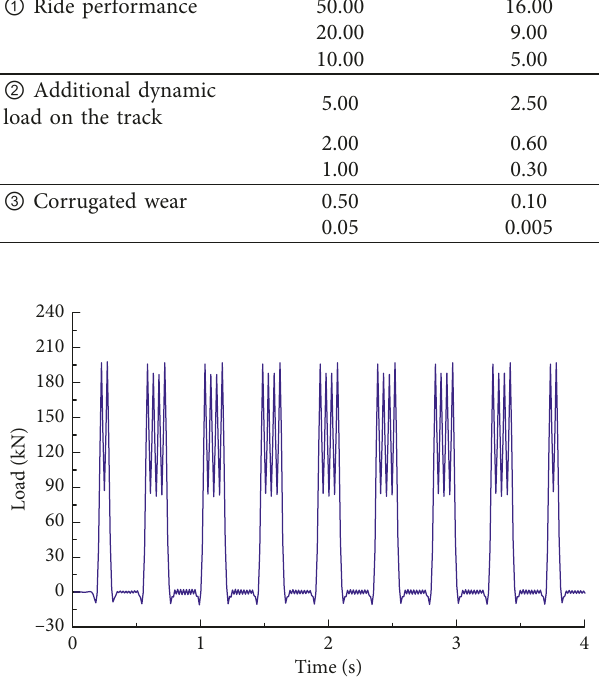
Figure 1: Time-history curve of train excitation